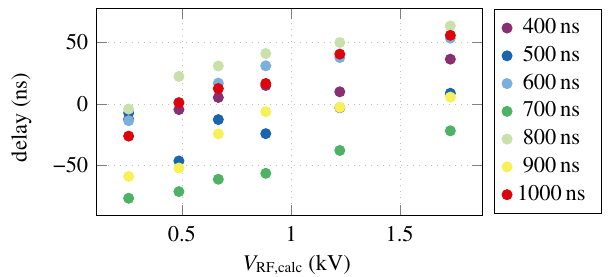
¼ 1 kV; frame rf ; set